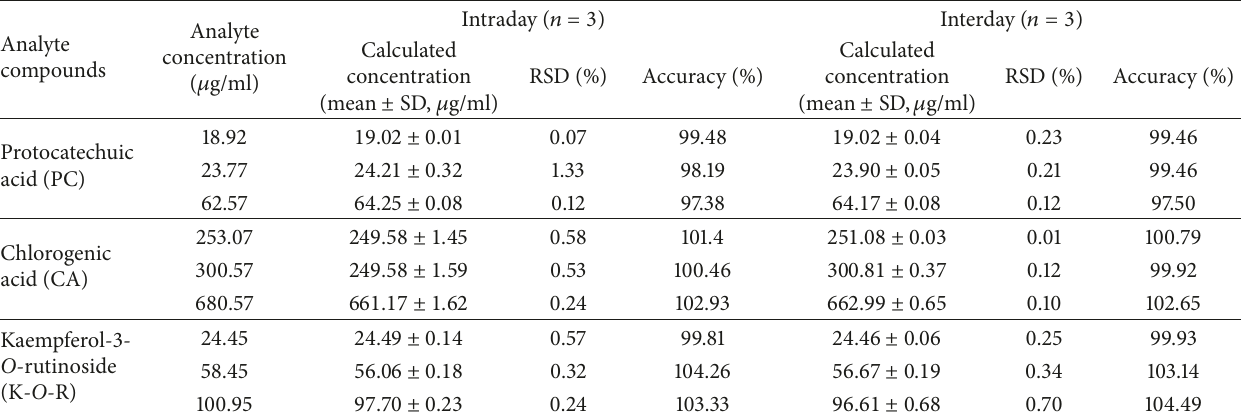
Table 2: Precision (intraday and interday) and accuracy of protocatechuic acid, chlorogenic acid, and kaempferol-3- O -rutinoside detection. Analyte